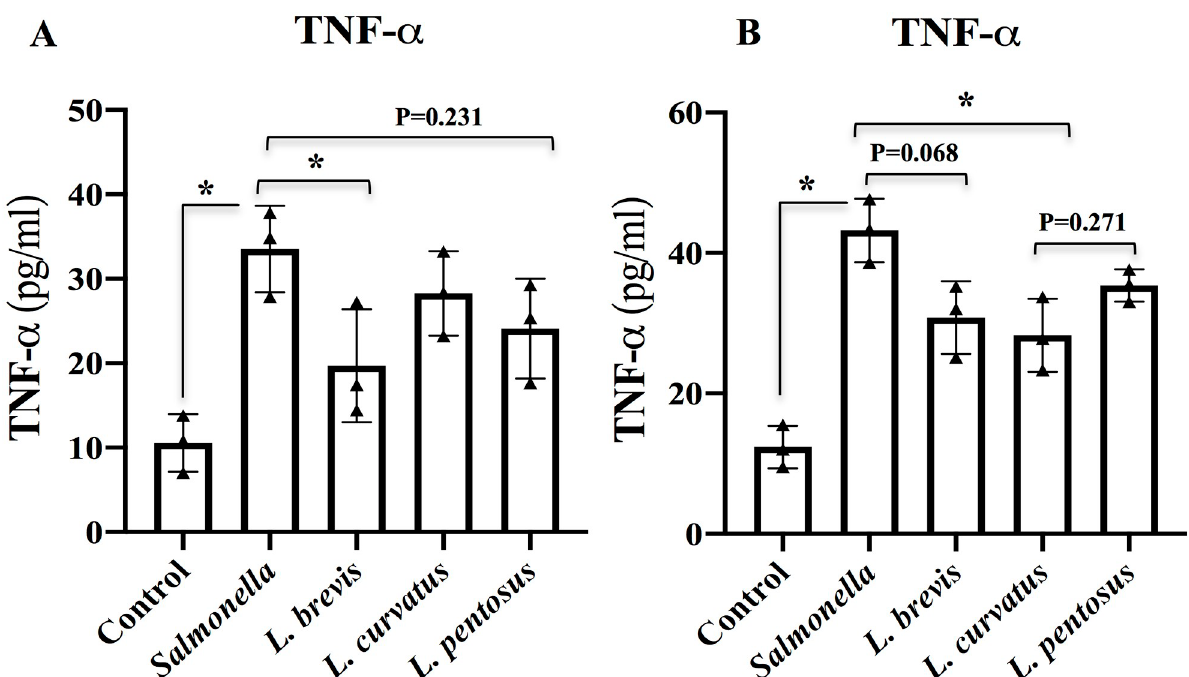
Fig 5. Lactobacillus strains ability to reduce TNF- α expression in HT-29 cells co-cultured with PBMCs. Apical HT-29 cells were stimulated with LABs for 48h, followed by stimulated with Salmonella for 12 h. The production of TNF- α in the apical (A) and basolateral (B) compartments was determined using ELISA. Cells treated either with medium or Salmonella alone were used as controls. The results represented here is an average values (mean ± S.D) of three independent values. Significant differences between the groups, � p < 0.05.